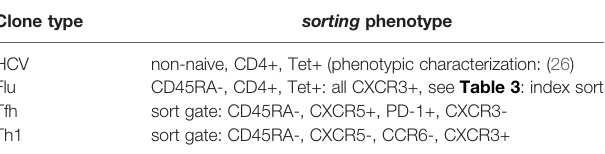
TABLE 2 | Sorting phenotype of CD4 T cell